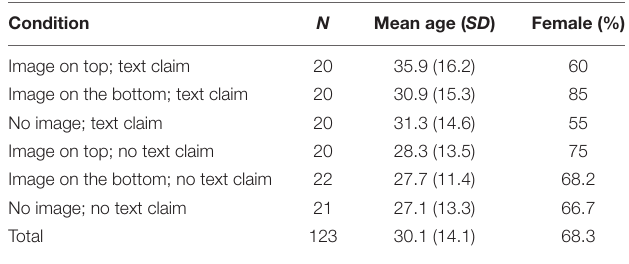
FIGURE 2 | Image on the bottom; the text